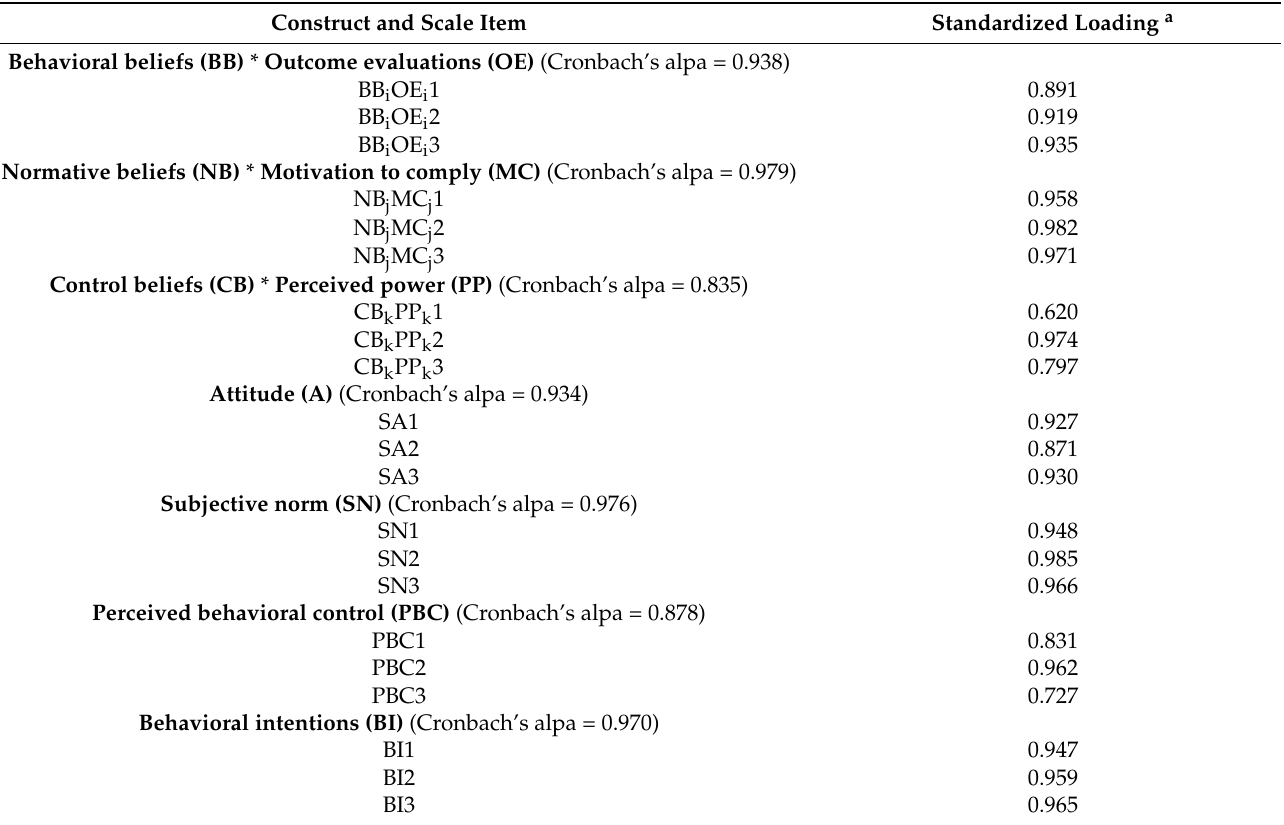
Table 1. Confirmatory factor analysis: items and